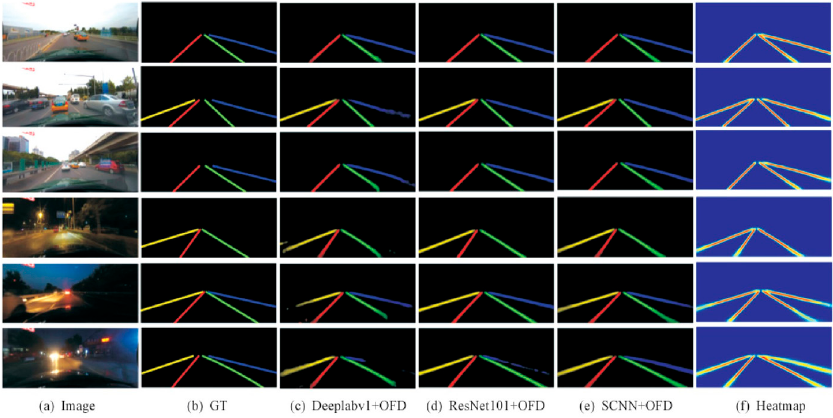
Figure 7. Lane line detection effect diagram before and after using the target feature distillation method.